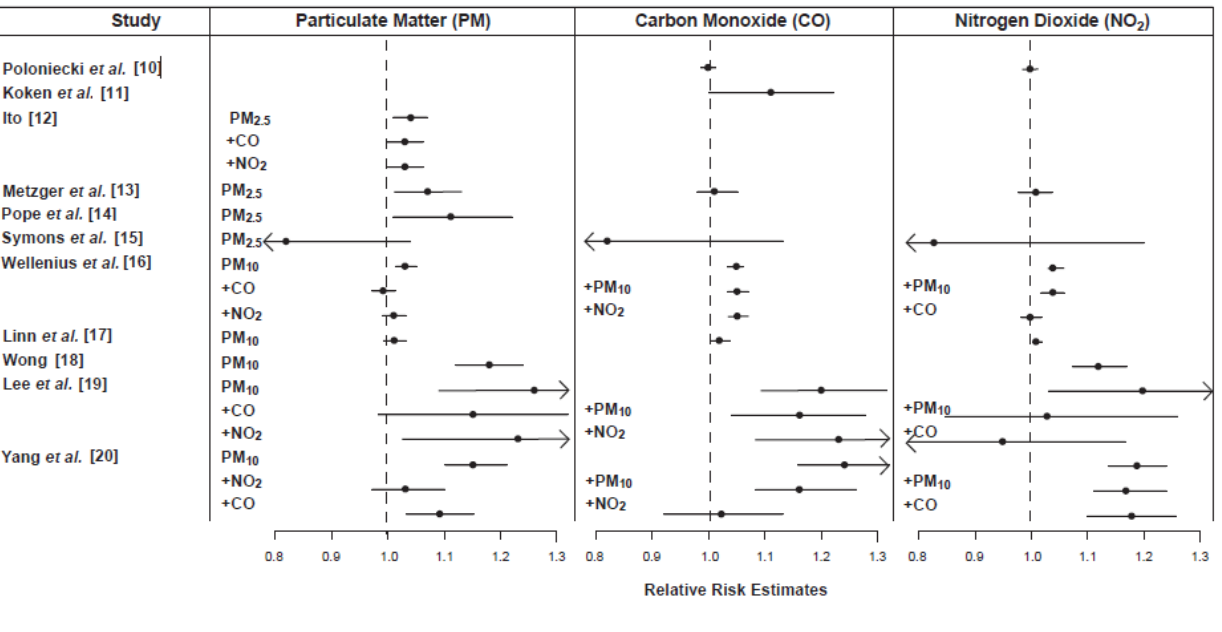
Figure 1. Effect estimates and 95% Confidence Intervals for Studies of Congestive Heart Failure (CHF) included in the analysis.